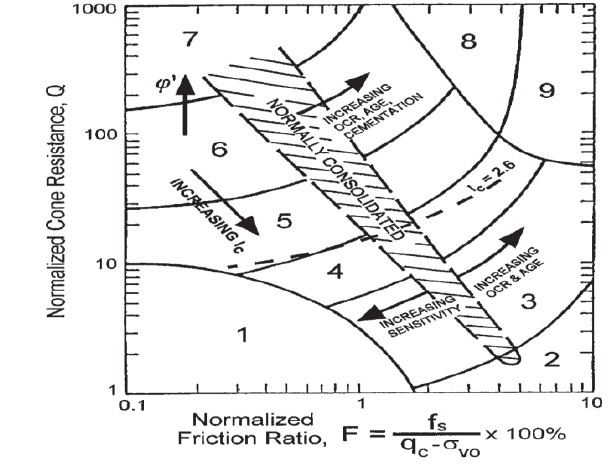
Figure 3: Normalized CPT soil behavior type chart, as proposed by (Robertson and Wride [15])